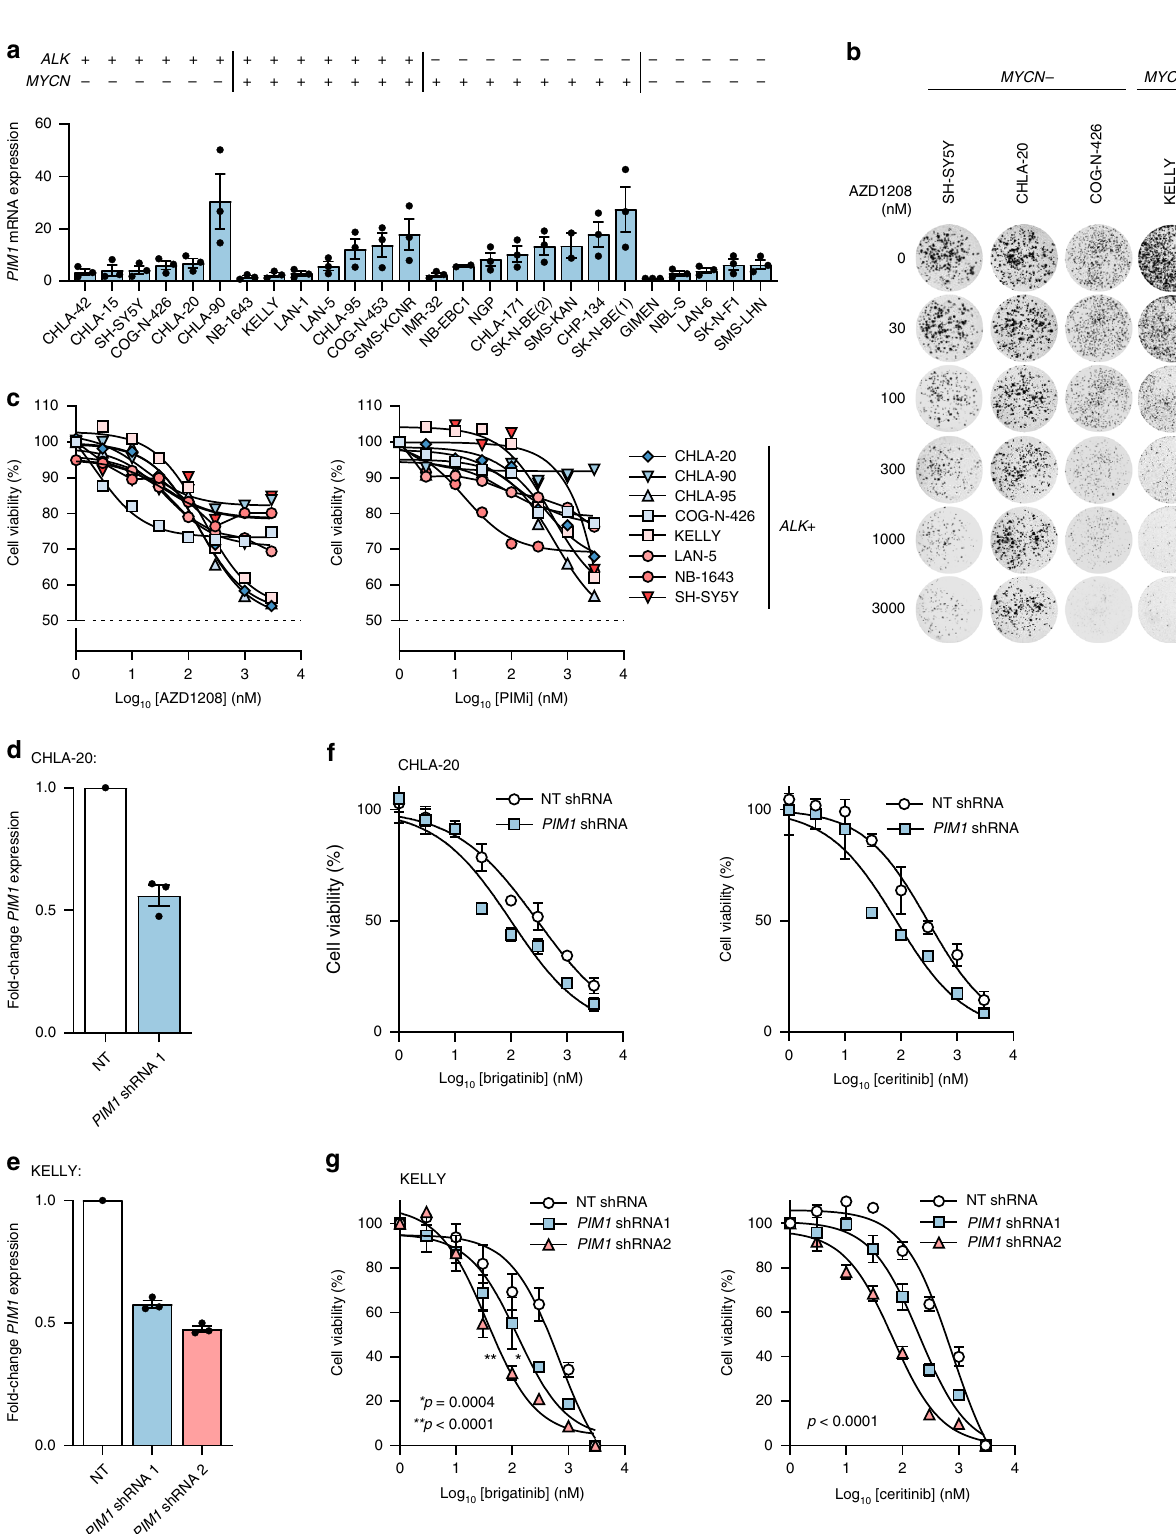
Fig. 3 PIM1 inhibition lacks potency but enhances the ef fi cacy of ALK inhibitors. a RT-qPCR-based expression levels of PIM1 in 25 neuroblastoma cell lines, normalized to GIMEN cell line expression levels. Data represent means ± s.d. of technical triplicates. b 14-day colony formation assay of ALK-positive NB cell lines treated with the indicated doses of AZD1208. c 72-h dose – response assays of ALK-positive NB cell lines treated with AZD1208 or PIMi. Data represent means ± s.d. of technical triplicates. d , e Analysis of PIM1 levels by RT-qPCR in d CHLA-20 or e KELLY cells with shRNA-mediated knockdown of PIM1 . NT, non-targeting. Data represent means ± s.d. of triplicate experiments. f , g 72-h dose – response assays following brigatinib or ceritinib exposure in f CHLA-20 cells or g KELLY cells treated with PIM1 -targeting or NT shRNA. Data points represent means ± s.d. of duplicate f or triplicate g experiments. ED 50 values were compared by an unpaired Student ’ s t -test. Source data for 3a and 3d-g are provided as a Source Data fi